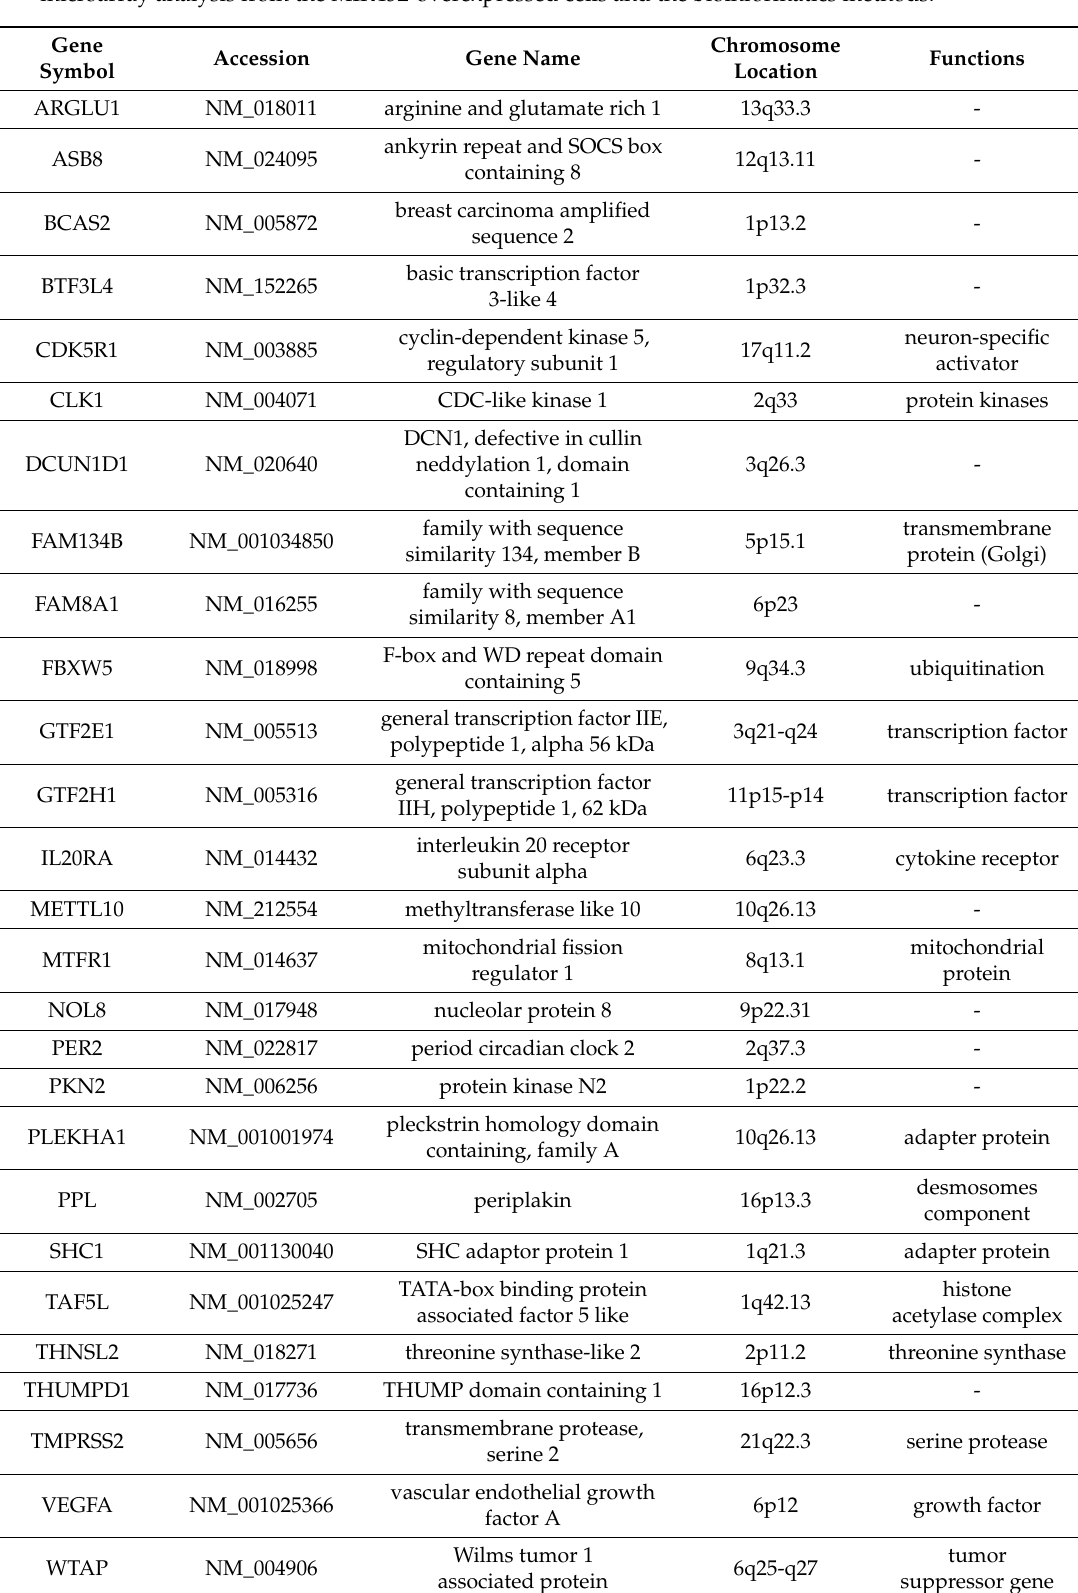
Table 1. The putative target genes of microRNA 452 (MIR452) identified and predicted by both the microarray analysis from the MIR452-overexpressed cells and the bioinformatics